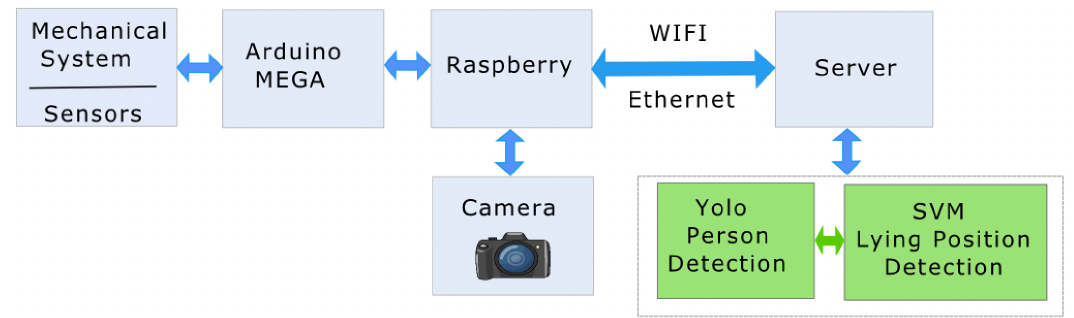
Figure 3. System-architecture